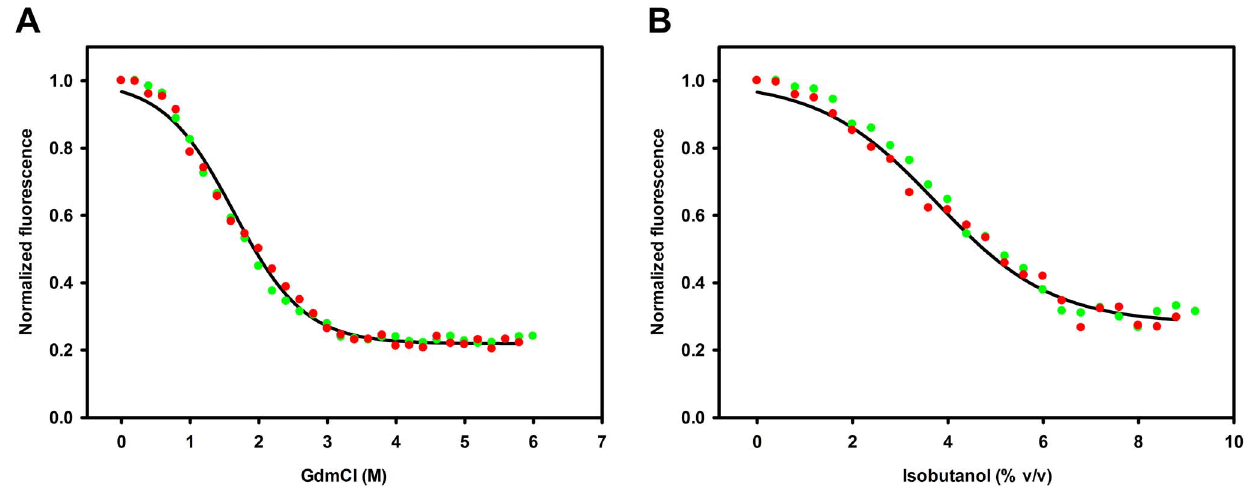
Figure 8. Fluorescence analysis of unfolding and refolding of Ta AlDH in the presence of A) GdmCl (25 u C) and B) isobutanol (40 u C). The fluorescence emissions of Ta AlDH at l =330 nm were monitored upon excitation at l max =280 nm. Data were collected for protein unfolding (red symbols) and refolding (green symbols) at indicated concentrations of GdmCl or isobutanol. The transition curve for protein unfolding is presented as the best fit using nonlinear regression (black curve).